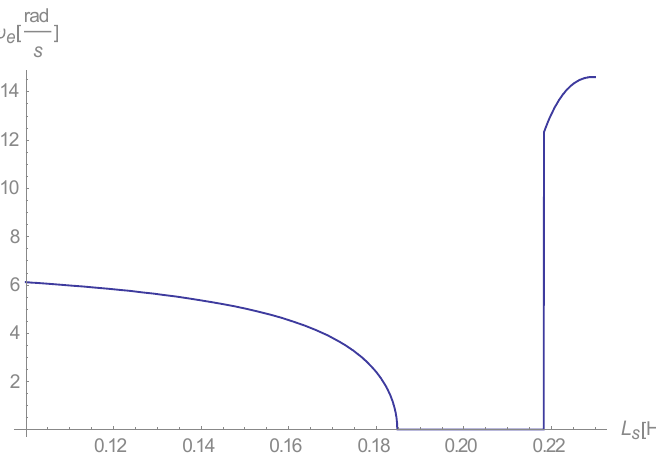
Figure 12. Plot of the imaginary part of the sixth solution of ω e (L S ).